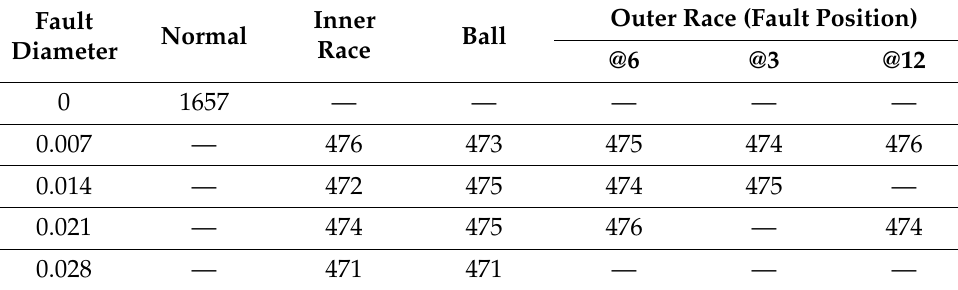
Table 2. Number of samples in each fault